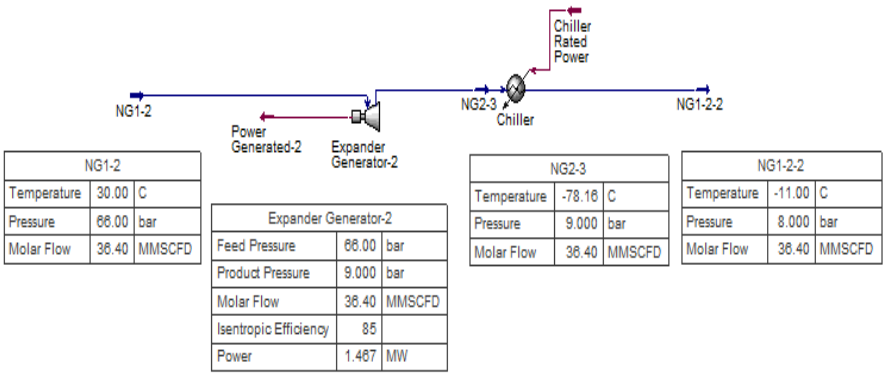
Figure 7. Modeling of scenario 3 using the commercially available software.